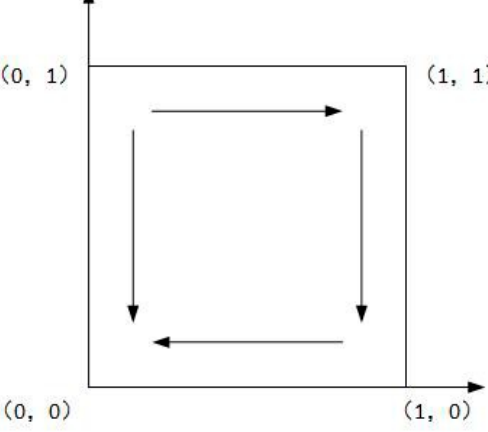
Figure 2. Phase diagram of Case 2.